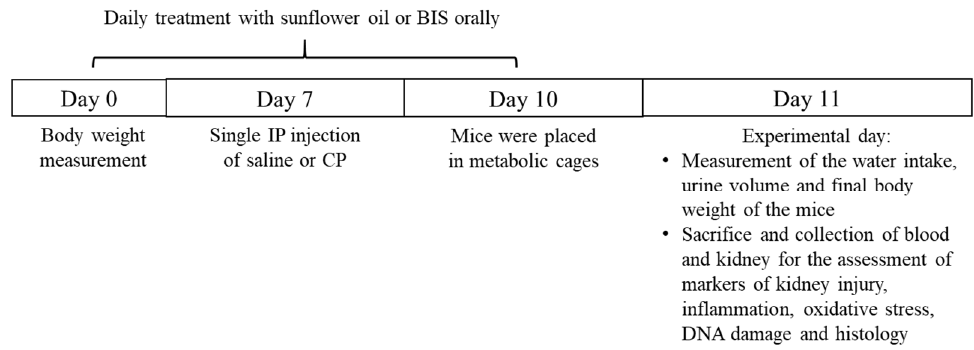
Figure 1. The treatments and endpoints following daily oral treatment of either sunflower oil or bisabolol (BIS, 25 mg/kg) with or without cisplatin (CP, 20 mg/kg) given intraperitoneally (IP). The bodyweight of the mice was recorded at the beginning of the study and right before sacrifice. On the day of the sacrifice, the mice were anesthetized with a dose of (60 mg/kg, IP) sodium pentobarbital. The blood was obtained via the inferior vena cava and centrifuged at 4 ◦ C for 15 min at 900 × g . The plasma samples were then stored at − 80 ◦ C pending analysis. The kidneys were excised and weighed. A small portion of the top part of the right kidney was excised and fixed in 10% formalin for histopathological analysis. The remainders of both right and left kidneys were rapidly wrapped and snap-frozen in liquid nitrogen and kept at − 80 ◦ C to await biochemical analysis.